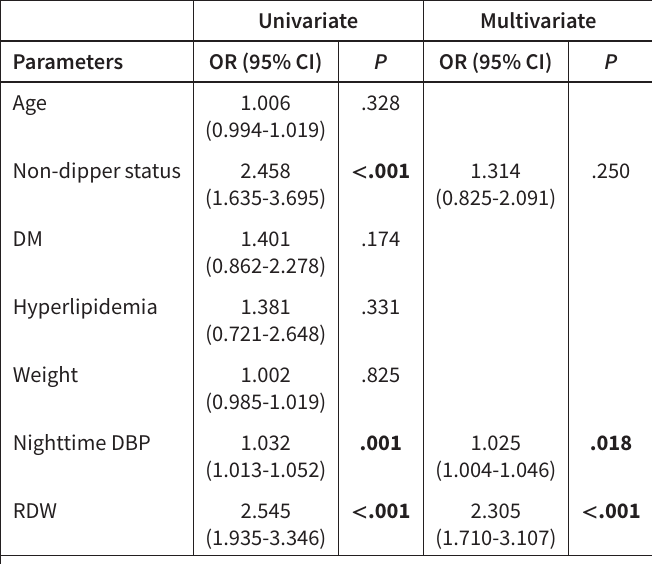
Table 2. Logistic Regression Analysis for LVH Presence Univariate